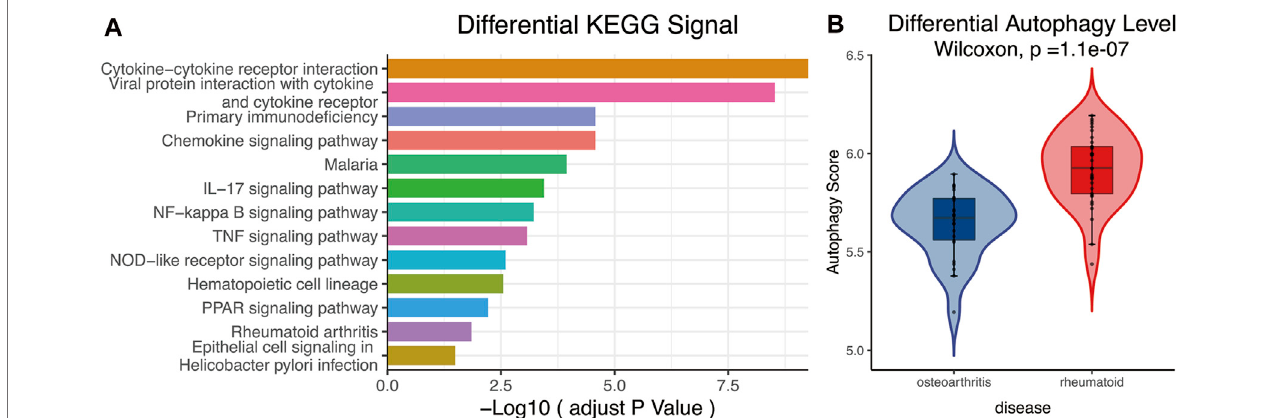
FIGURE 3 | (A) KEGG analysis. The different signaling pathways were differentially enriched in RA and OA, and multiple important autophagy-related signaling pathways were present, including NF-kappa B, TNF, NOD-like receptor, and PPAR. (B) ssGSEA analysis. Results showed autophagy levels between OA and RA were signi fi cantly different, the autophagy level of RA being higher than that of OA. KEGG, Kyoto Encyclopedia of Genes and Genomes; ssGSEA, single-sample gene-set enrichment analysis.